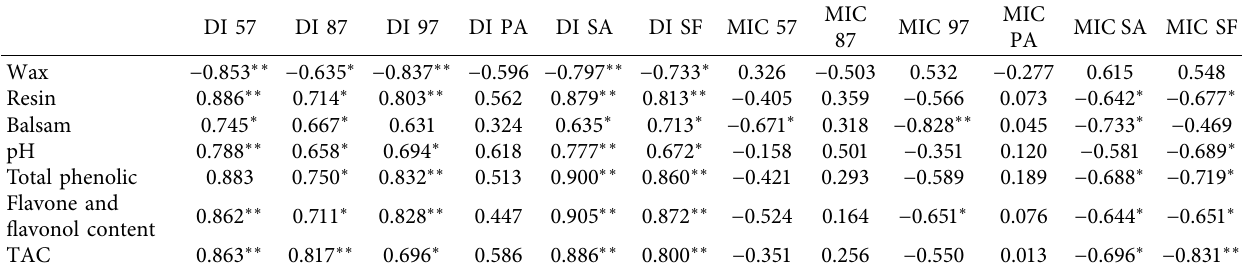
Table 6: Pearson correlation coefficients between the analyzed parameters and antibacterial